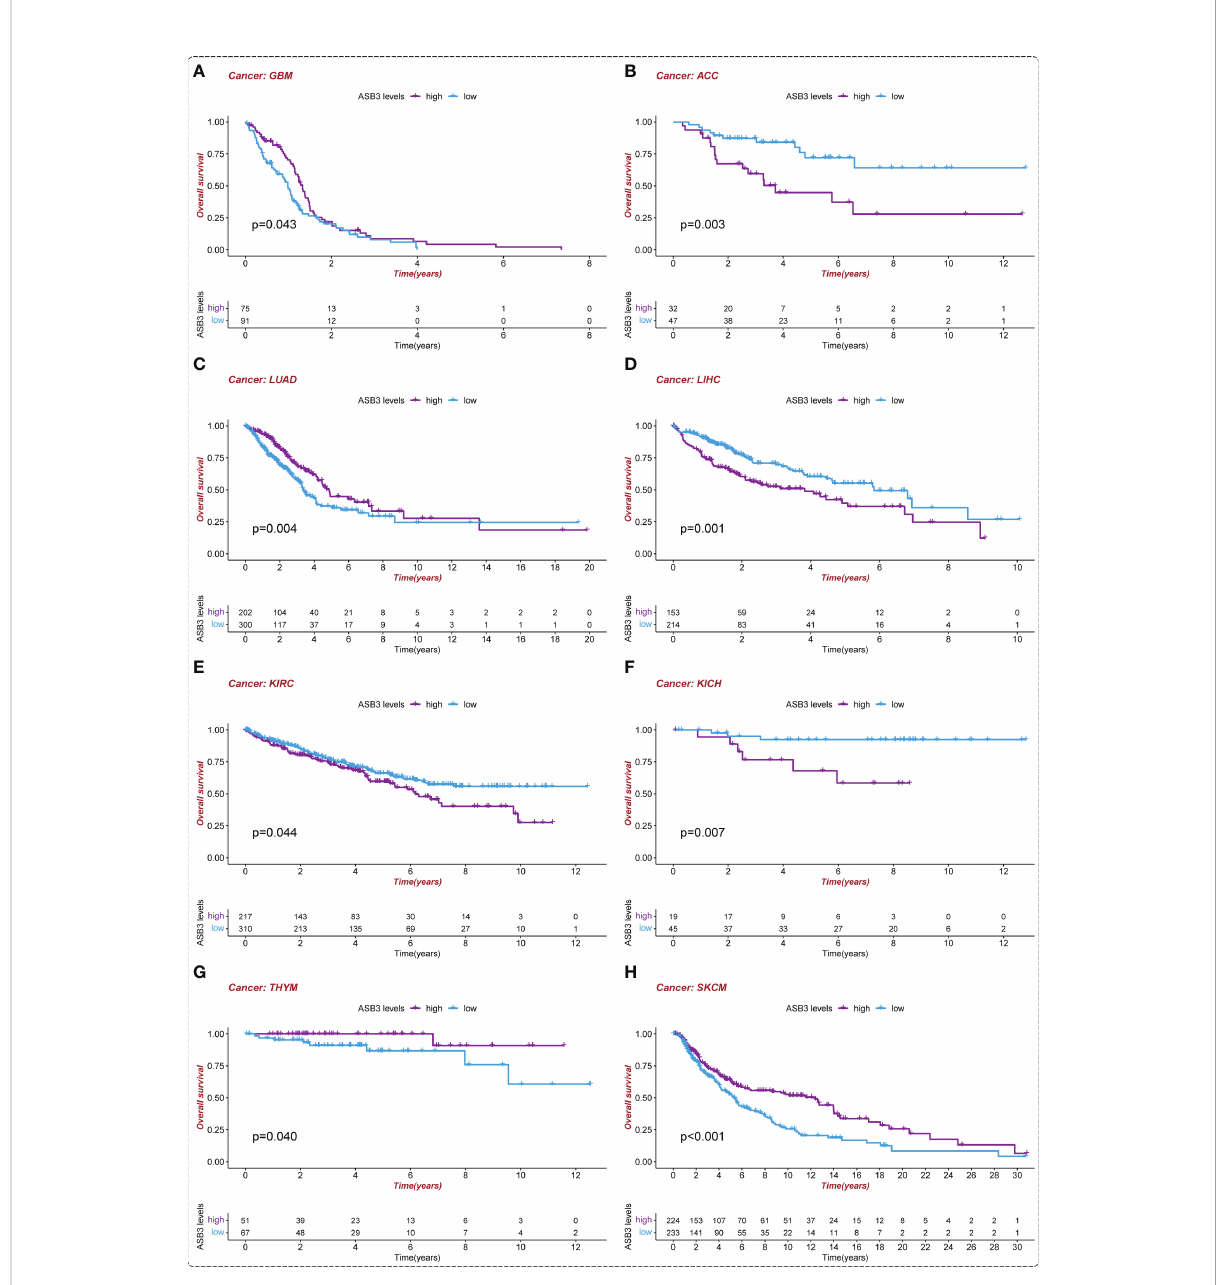
FIGURE 4 Kaplan-Meier survival analysis of ASB3 in pan-cancer. (A) The overall Kaplan-Meier survival analysis for ASB3 in GBM, (B) ACC, (C) LUAD, (D) LIHC, (E) KIRC, (F) KICH, (G) THYM and (H)